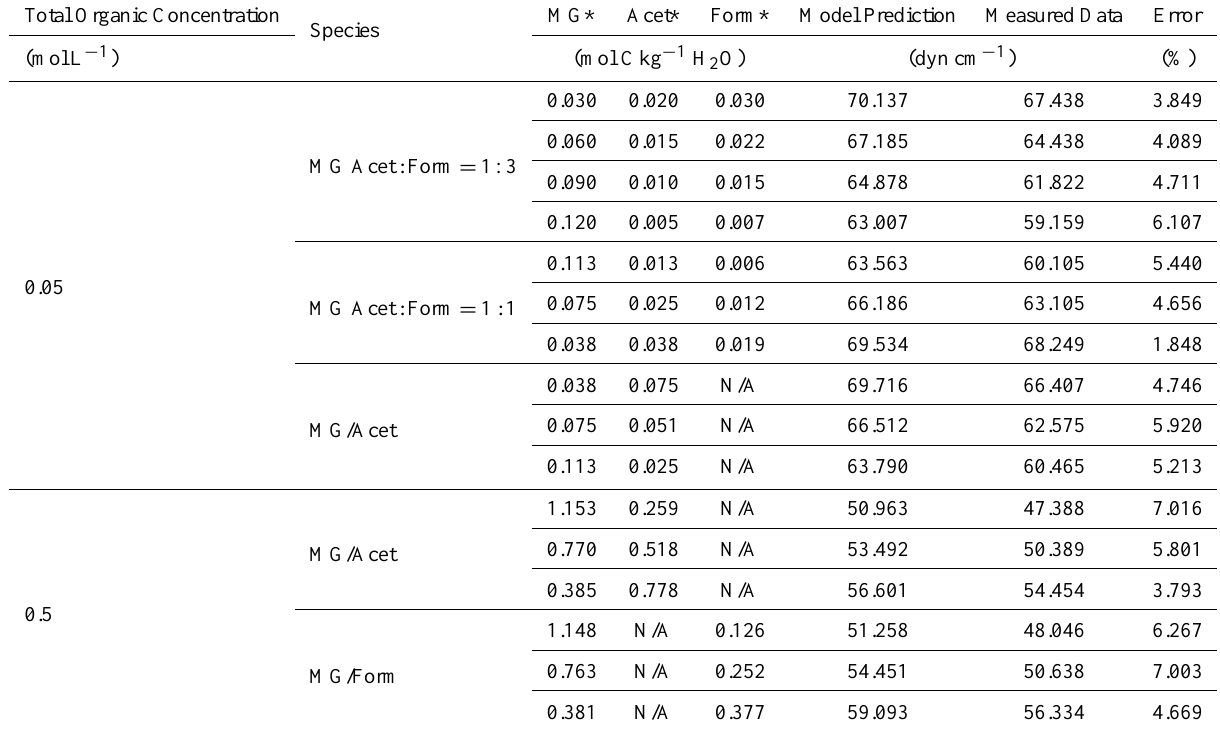
Table S1. Calculated errors between the Henning model predictions (using Eq. 3) and experimentally measured surface tension values. Total Organic Concentration MG* Acet* Form* Model Prediction Measured Data Species